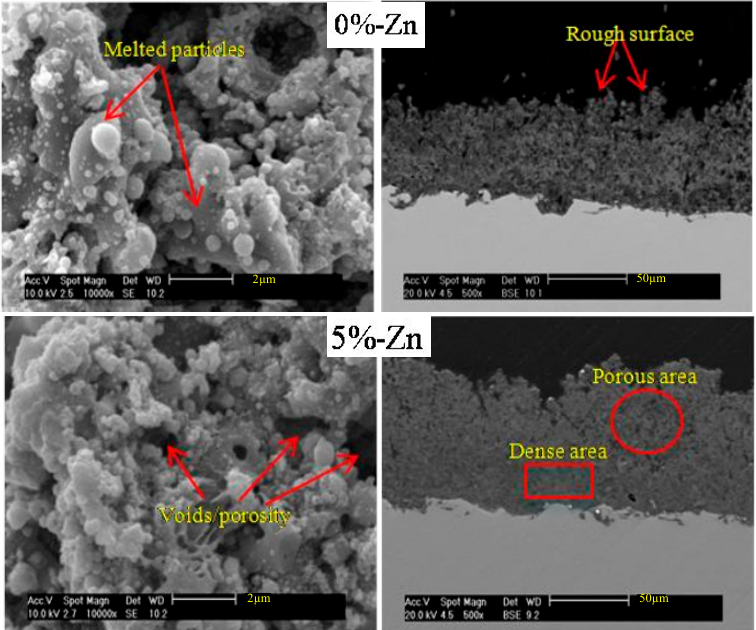
Figure 12. SEM images at the ( left ) surface and ( right ) cross-section of the coatings of (0%-Zn) un-doped HA and (5%-Zn) Zn-doped HA. Reproduced with permission from [13], Elsevier, 2018.